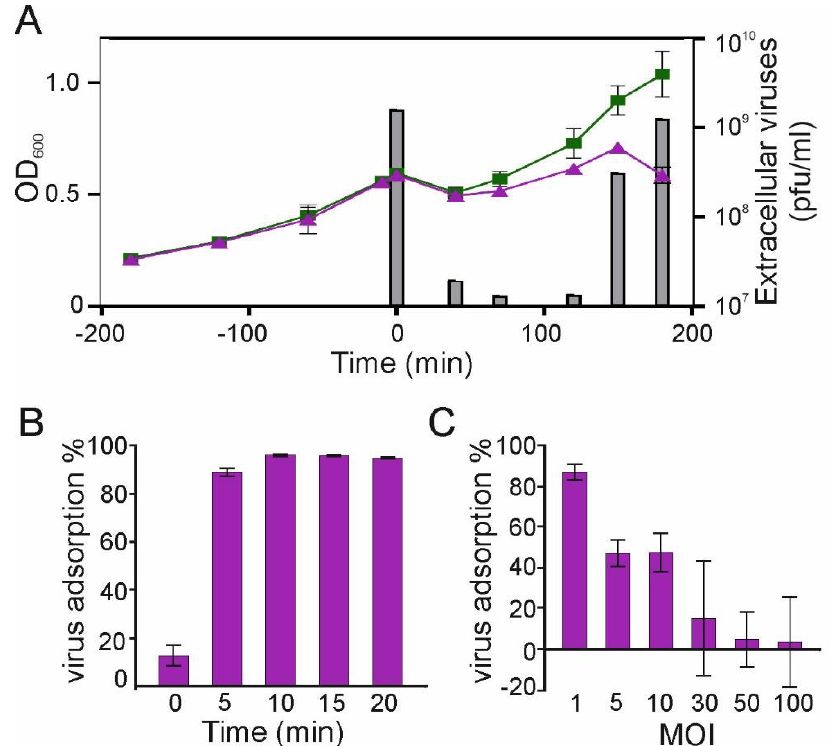
Figure 1. Characterization of phage 1/4 infection . ( A ) Growth curves of MOI 10-infected and mock-infected S. glacialimarina . The columns depict the number of extracellular viruses (pfu/mL) at different time points of the infection. ( B ) Shewanella phage 1/4 adsorption dynamics following the addition of a fixed number (1.5 × 10 3 ) of virions at t 0 min . ( C ) Host receptor saturation assay showing phage 1/4 adsorption at t 10 min in response to increasing MOI values. Error bars show the standard deviation ( n = 3).